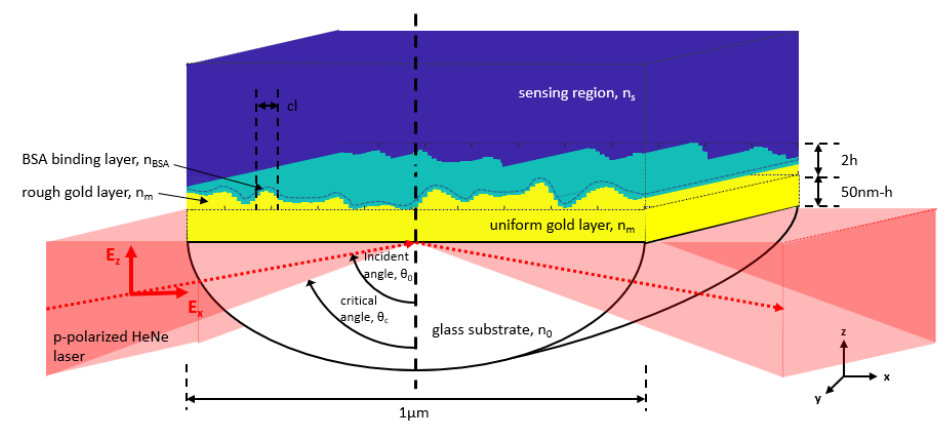
Figure 3. Simulated rough SPR sensor based on the Kretschmann configuration.